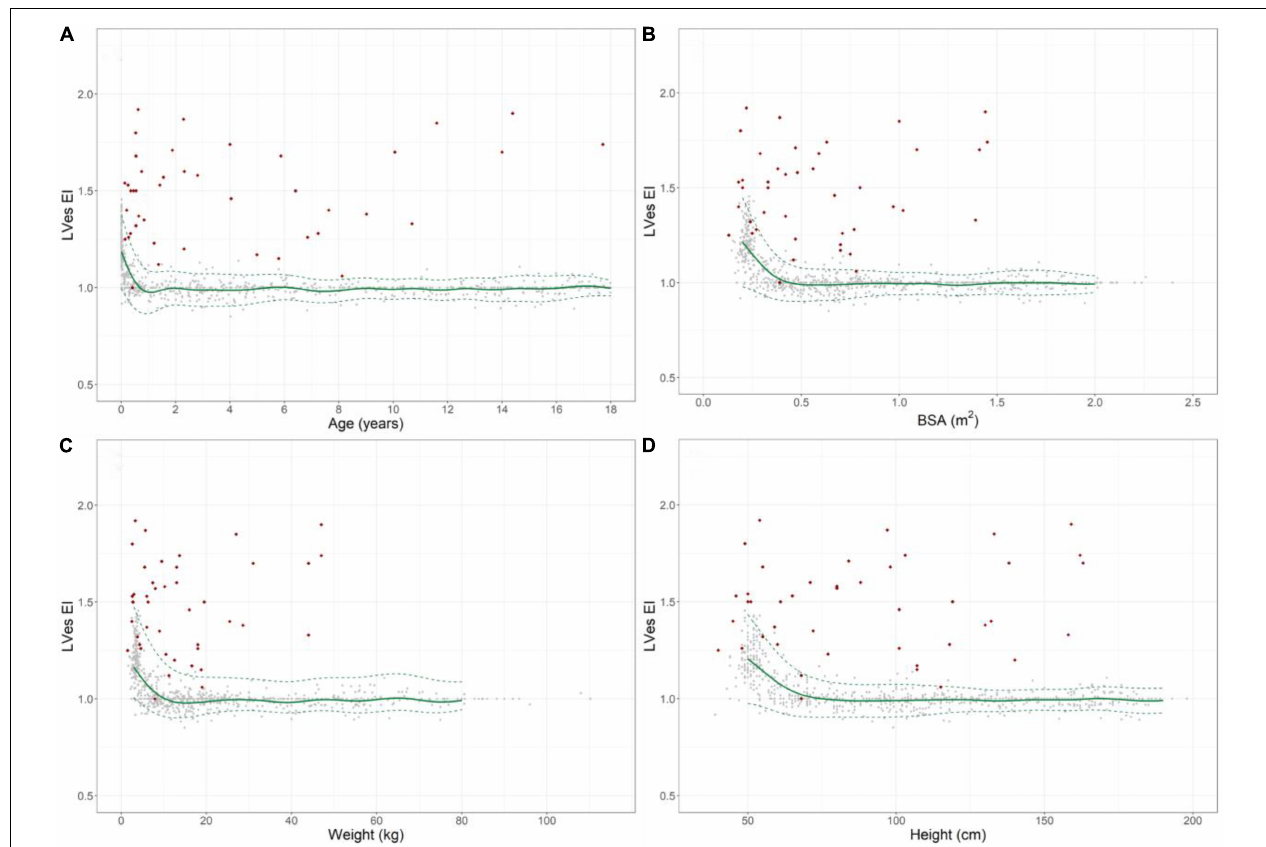
FIGURE 3 | Normal reference values for LVes EI (LV endsystolic eccentricity index) in healthy children and individual levels of pulmonary hypertension patients (red diamonds). Normal change of LVes EI with increasing (A) age, (B) BSA, (C) weight, and (D) height (gray circles: individual values; green solid line: median, dashed green line: 2.5 and 97.5%